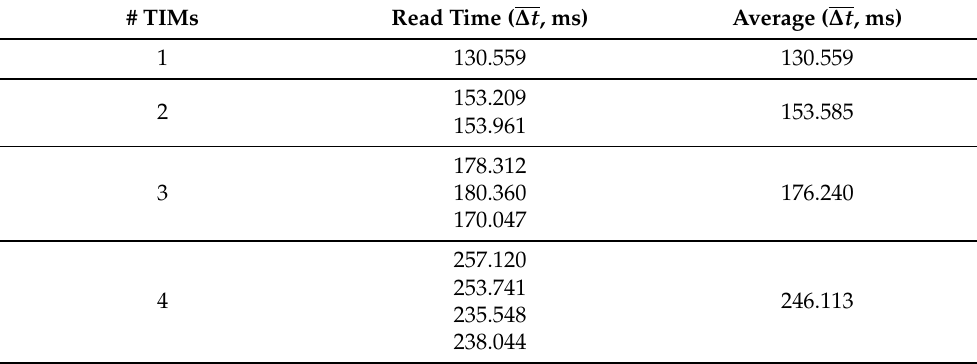
Table 5. Read Sensor Tests—Total Times, with DINASORE.